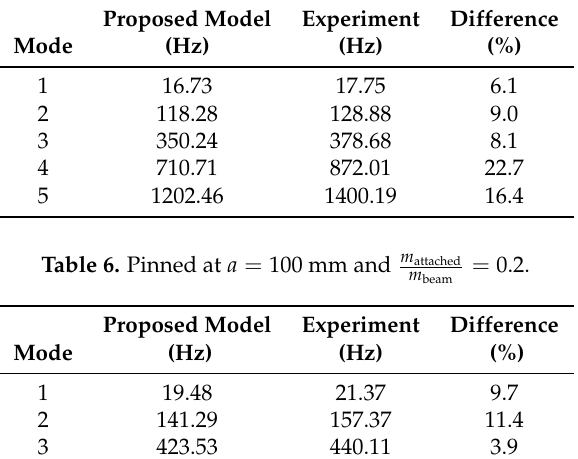
Table 5. Pinned at a = 50 mm and m attached